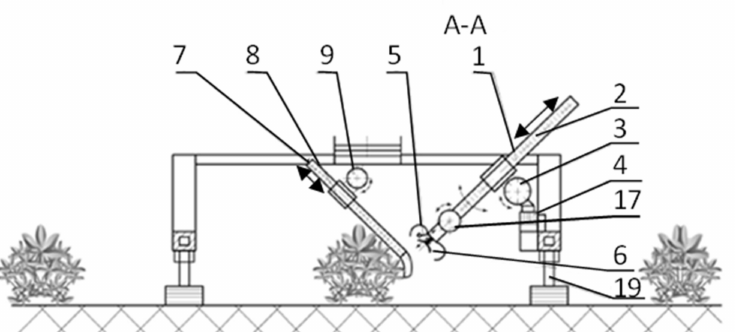
Figure 2. The working section of the harvester for harvesting strawberries, in a schematic view in section A—A: 1—working head arm; 2—rack of the longitudinal feed mechanism; 3—rotation mechanism in the vertical plane; 4—head arm rotation mechanism in the horizontal plane; 5— camera identifying the picked fruit; 6—pull-out suction cup; 7—comber arm; 8—longitudinal feed mechanism; 9—rotation mechanism in the vertical plane; 17—rotation mechanism in the vertical plane; 19—telescopic shock-absorbing suspension system. Source: Reprinted with permission from ref. [43]. Source: Reprinted with permission from ref. [43]. Copyright in proceeding Copyright